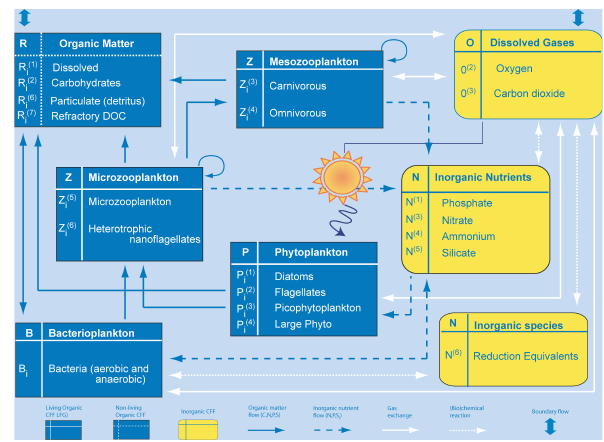
Fig. 2. Compartments and processes in the Biogeochemical Flux Model. Scheme modified from Vichi et al. (2007a), Copyright ©2006, with permission from